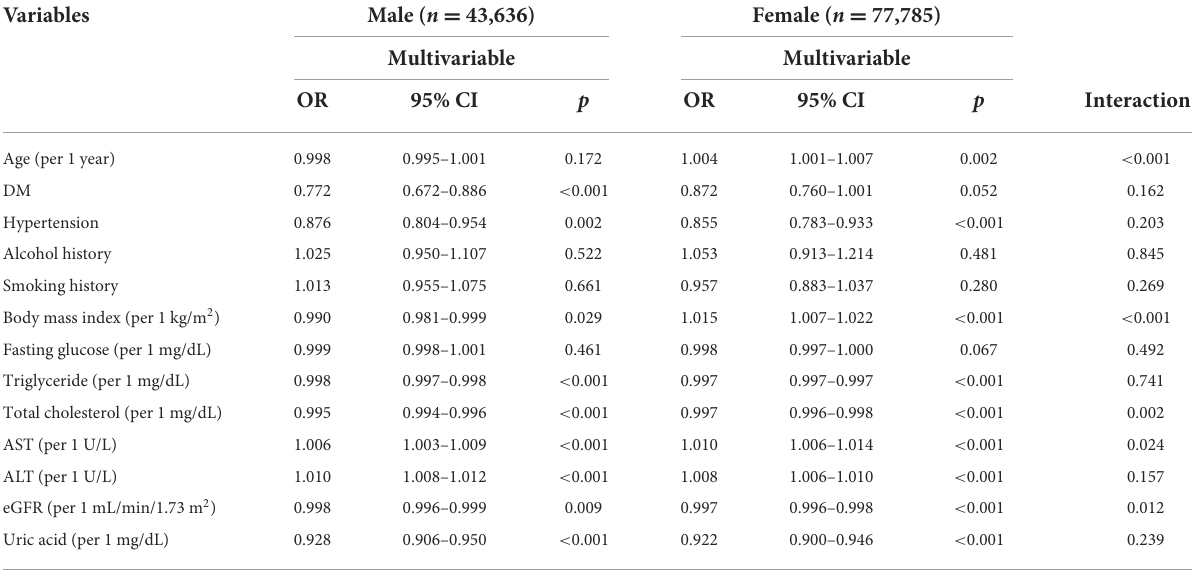
TABLE 3 Determinants for HBV by the presence of different sex using multivariable logistic regression analysis. Variables